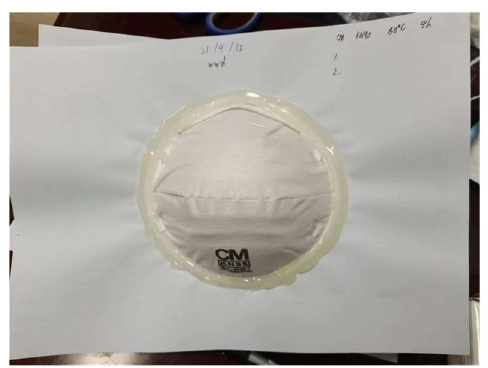
Figure 3. The sample after treatment.